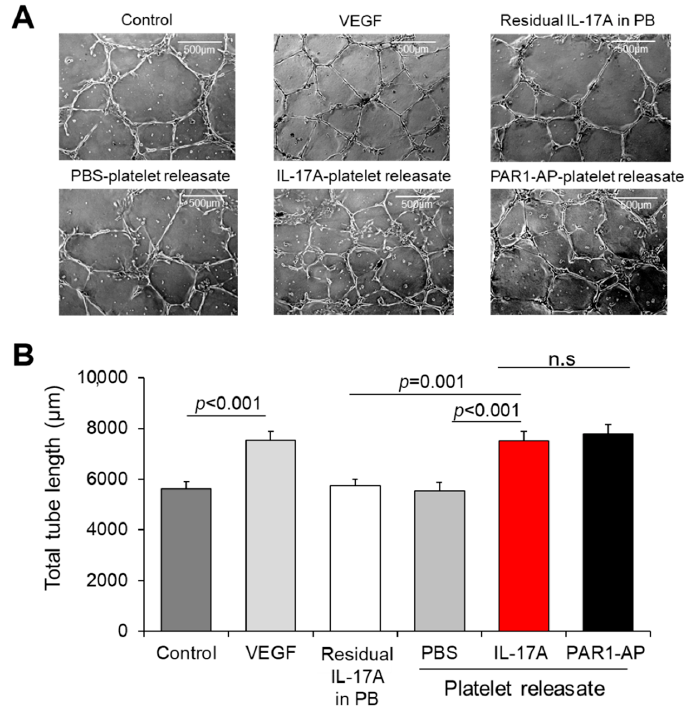
Figure 3. IL-17A-treated platelet releasate promotes endothelial cell tube formation. ( A ) Capillary tube formation in Matrigel-coated wells following exposure of human umbilical vein endothelial cells (HUVECs) to VEGF (10 ng/mL), residual IL-17A alone in platelet buffer (at a final concentration of 5 ng/mL) or to releasate from platelets prior incubated with IL-17A (50 ng/mL), PAR1-AP (100 μΜ ) or PBS (resting platelets) for 18 h. ( B ) Quantification of cumulative tube length was determined in 10 non-overlapping fields. Values are presented as the mean of total tube length ( μ m) ± SEM of three independent experiments. With regard to statistics, adjusted p -value as determined by one-way ANOVA and Bonferroni’s multiple comparison test is reported per indicated comparison. No statistical significance is denoted as n.s. Scale bars indicate 500 μ m.